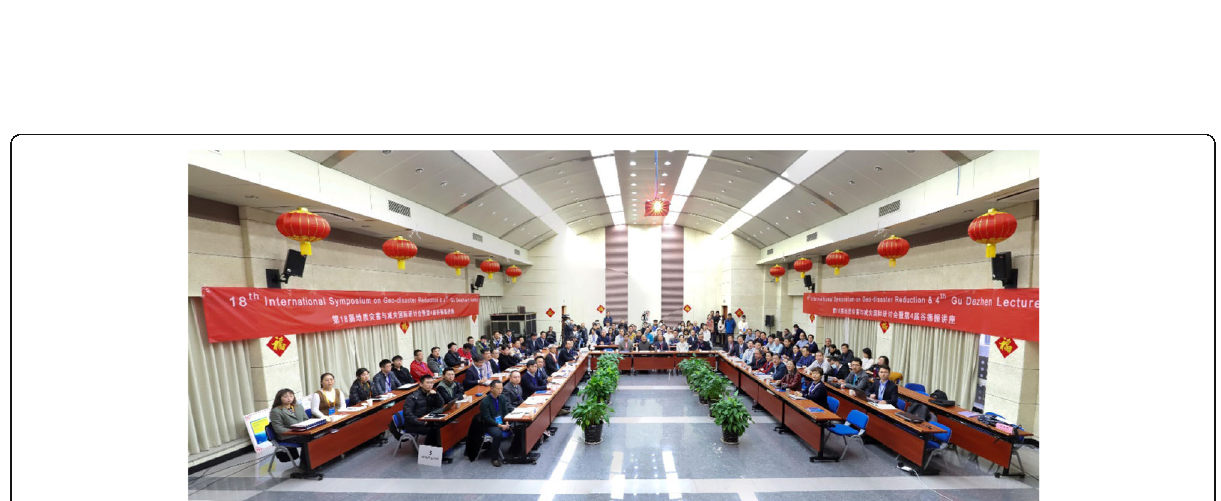
Fig. 2 Group photo of participants of the 18th